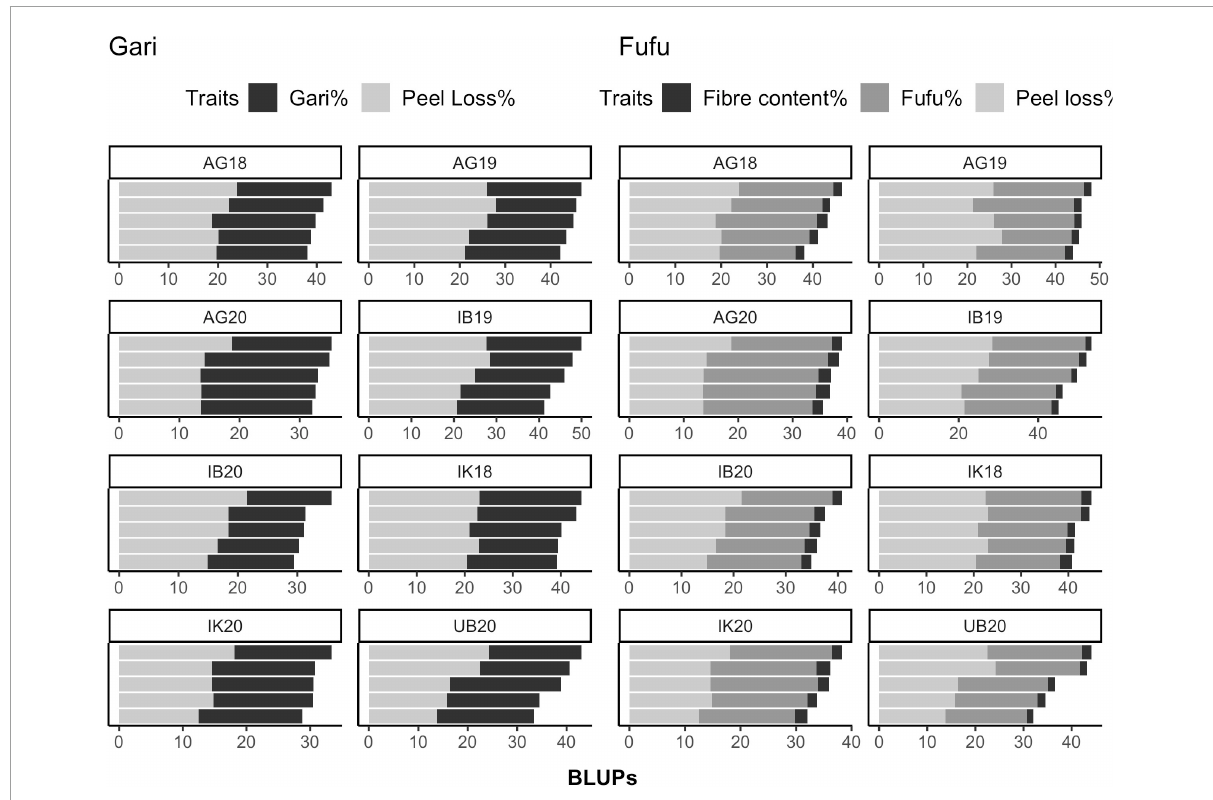
FIGURE3 Relationship between gari and fufu % and processing loss traits for eight environments. IB19, Ibadan 2019; IK18, Ikenne 2018; AG19, AgoOwo 2019; UB20, Ubiaja 2019; IK20, Ikenne